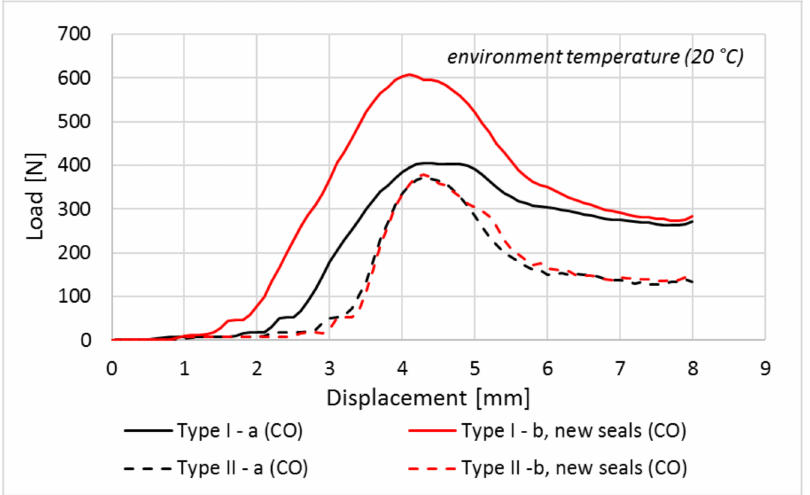
Figure 16. Closing force curves obtained at environmental